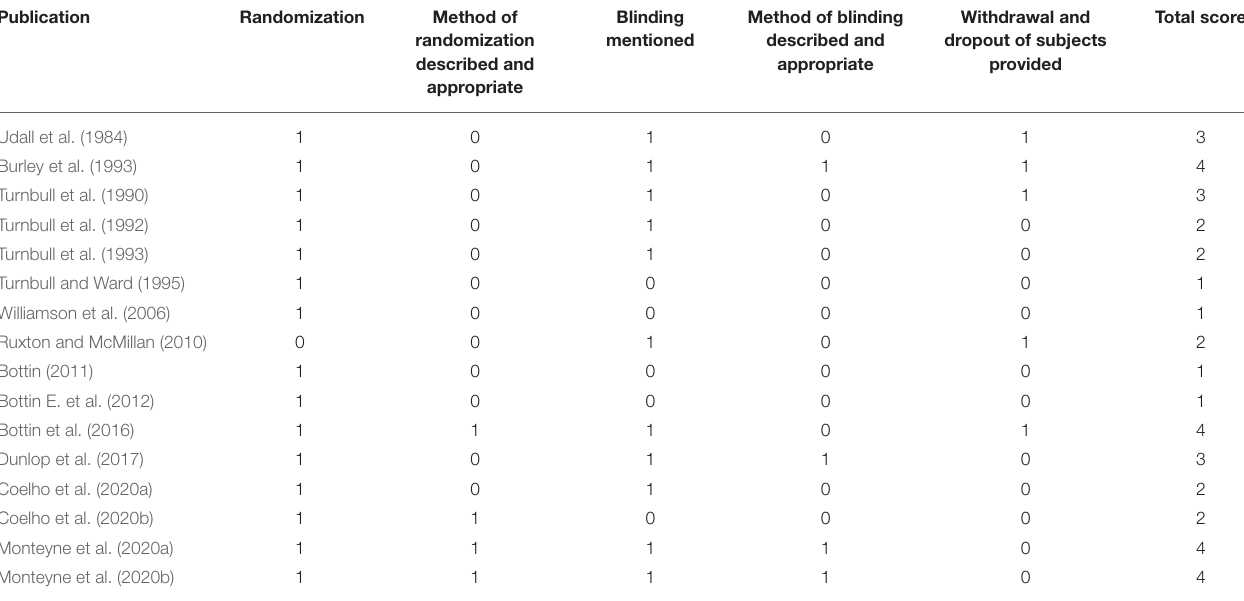
TABLE 4 | Assessment scale used to assess the quality of